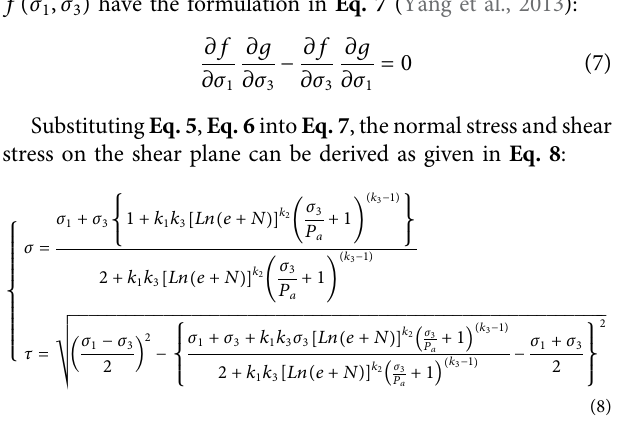
Frontiers in Earth Science |